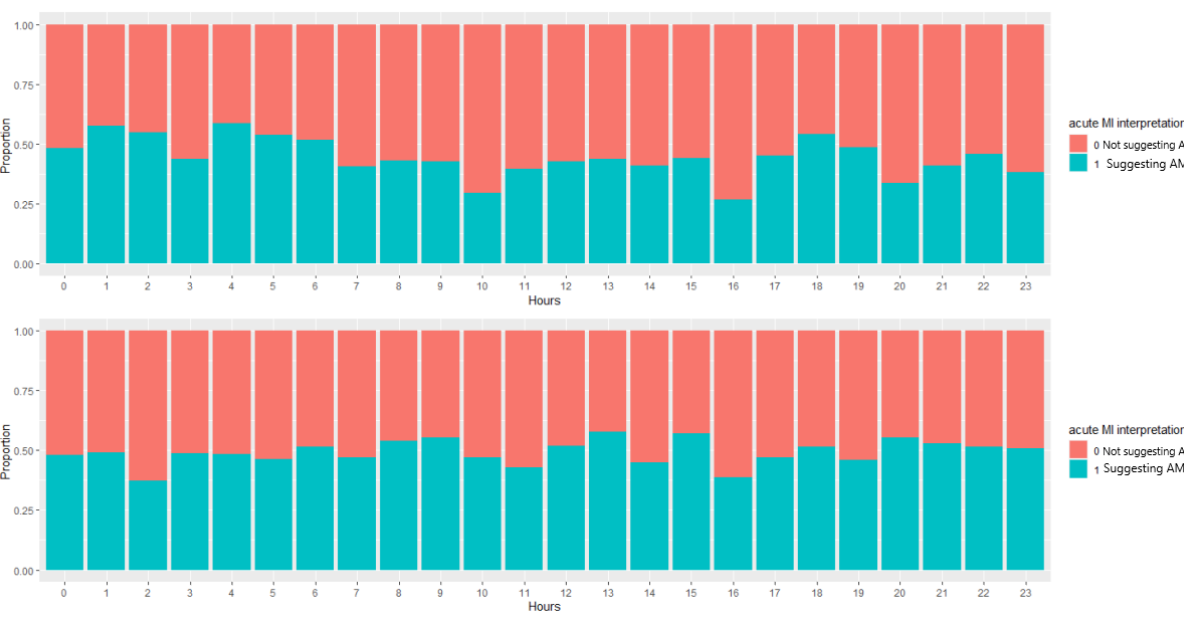
Figure 1. (a) Activator nurse and (b) computer interpretations of acute myocardial infarction rate by the hour. AMI: acute myocardial infarction; MI: myocardial infarction.